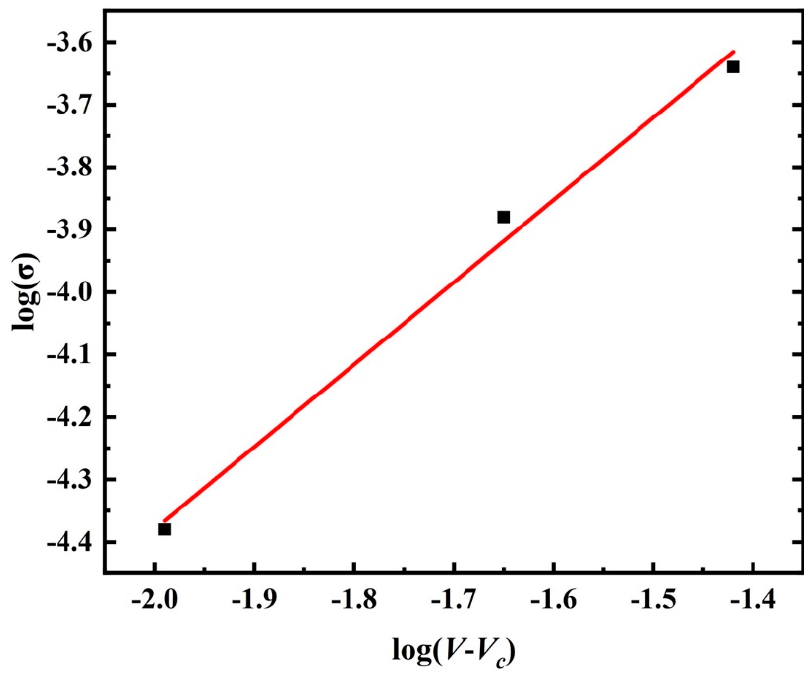
Figure 8. Classical percolation theory.